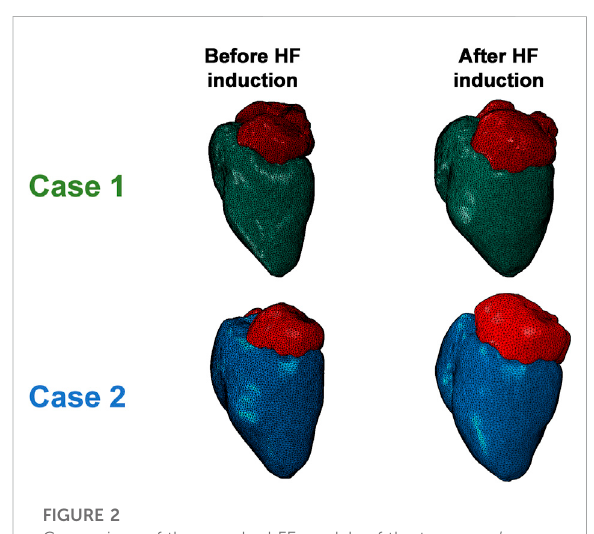
FIGURE 2 Comparison of the morphed FE models of the two cases ’ anatomies before and after HFpEF